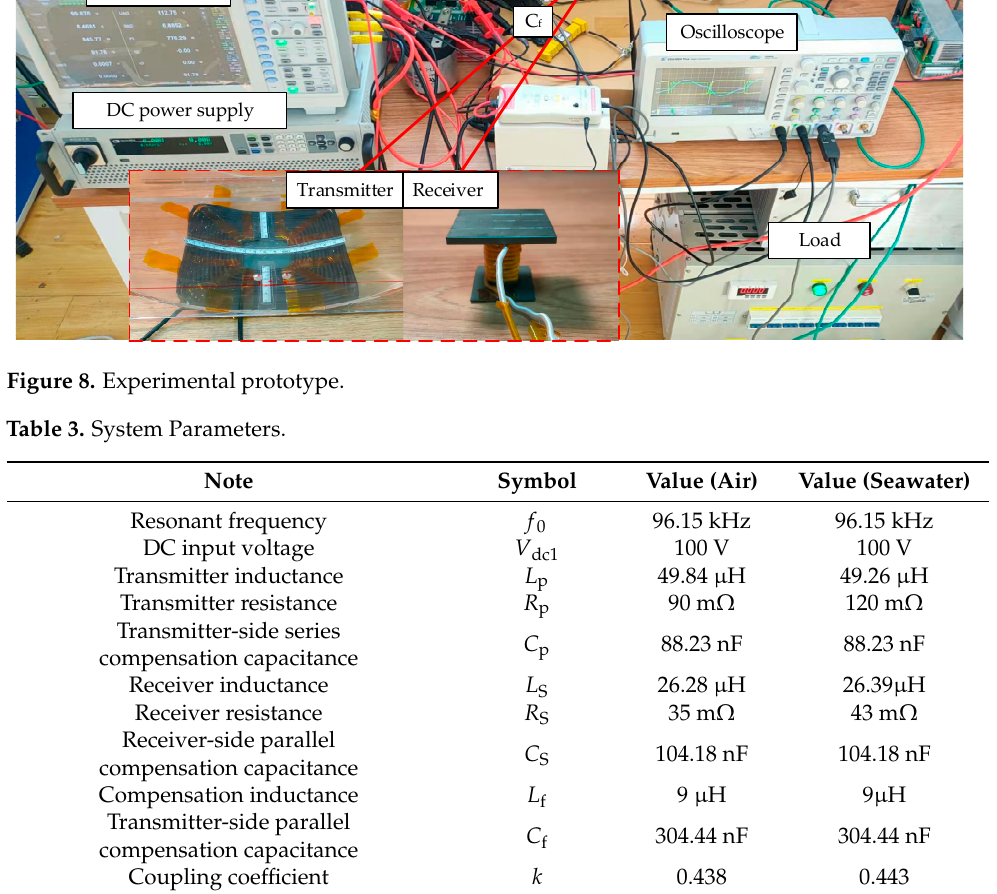
( b ) Figure 7. Frequency characteristics of IPT system under different loads. ( a ) Input impedance angle variation with frequency; ( b ) G V variation with frequency.